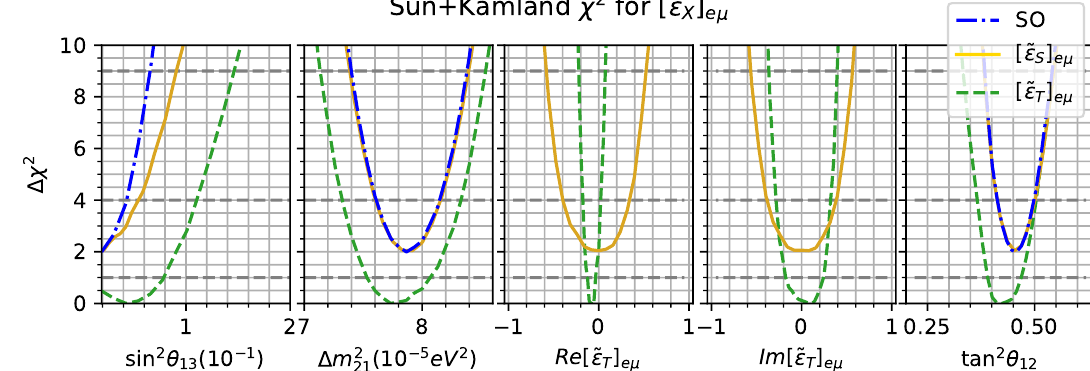
, tan 2 θ , ∆ m 2 , < [˜ (cid:15) ] and = { [˜ (cid:15) ] 13 12 X eµ X eµ } 21